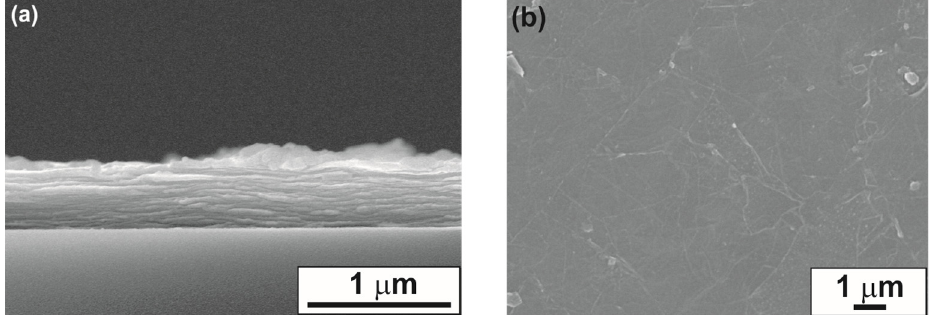
Figure 3. SEM images of MXene (Ti 3 C 2 Т х ) film: cross section ( a ) and top view ( b ).